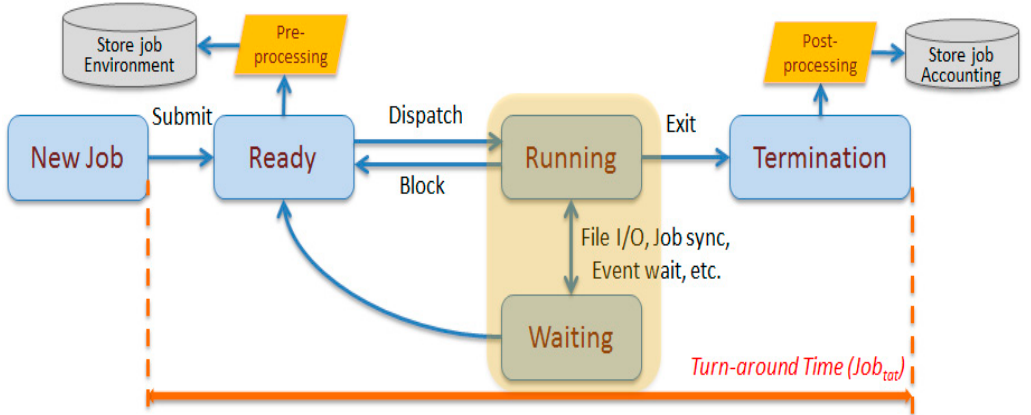
Figure 2. Procedure for the job running using a batch job scheduler.